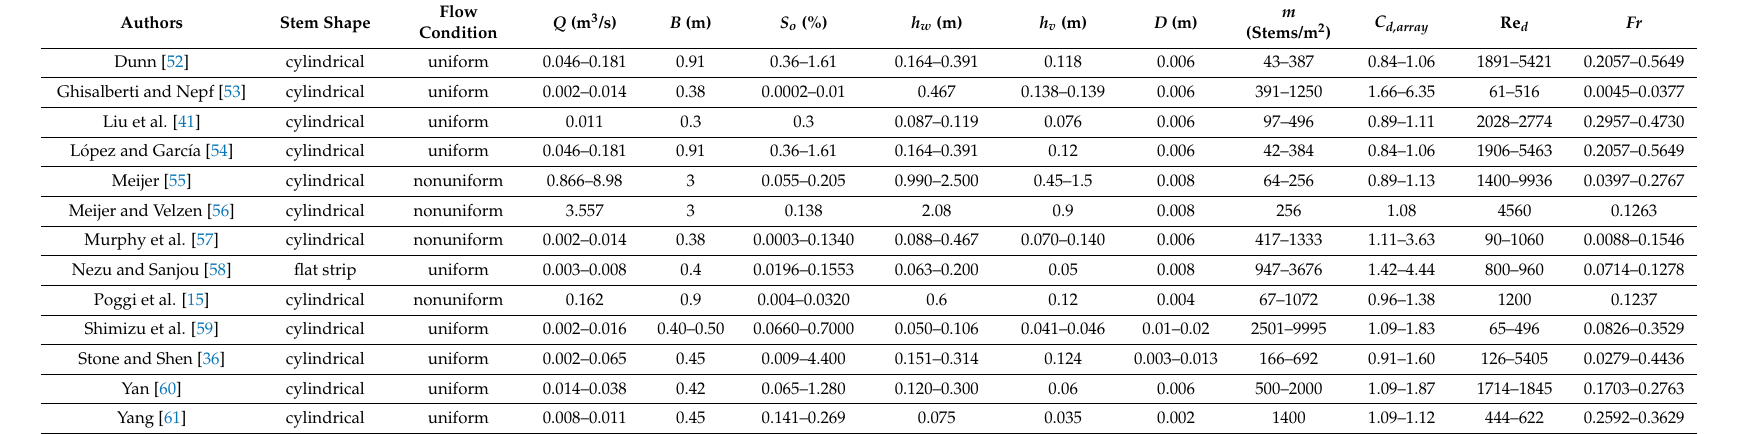
Table 1. Summary of experimental data for flow through rigid